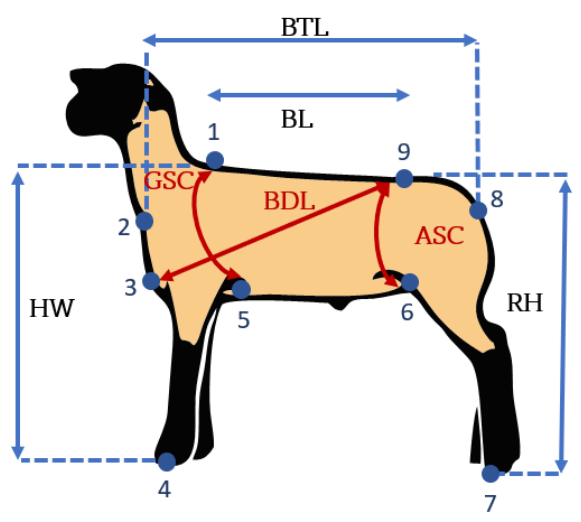
Figure 8. Schematic of the body